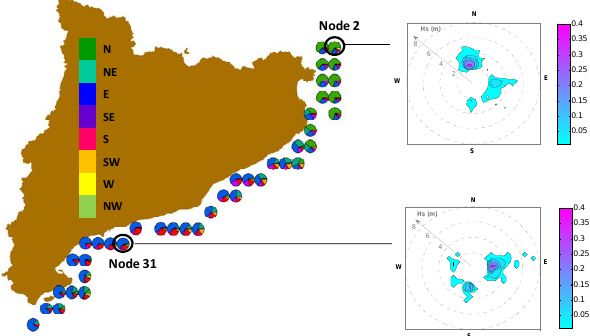
Fig. 1. Left: circular graphs of wave direction frequency along Figure 1. Left: circular graphs of wave direction frequency along the Catalan coast in the 2 the Catalan coast in the period 1958–2001 (areas proportional to period 1958-2001 (areas proportional to the percentages). Right: two examples of joint 3 the percentages). Right: two examples of joint probability density probability density function of each couple of Hs and wave direction. 4 function of each couple of Hs and wave